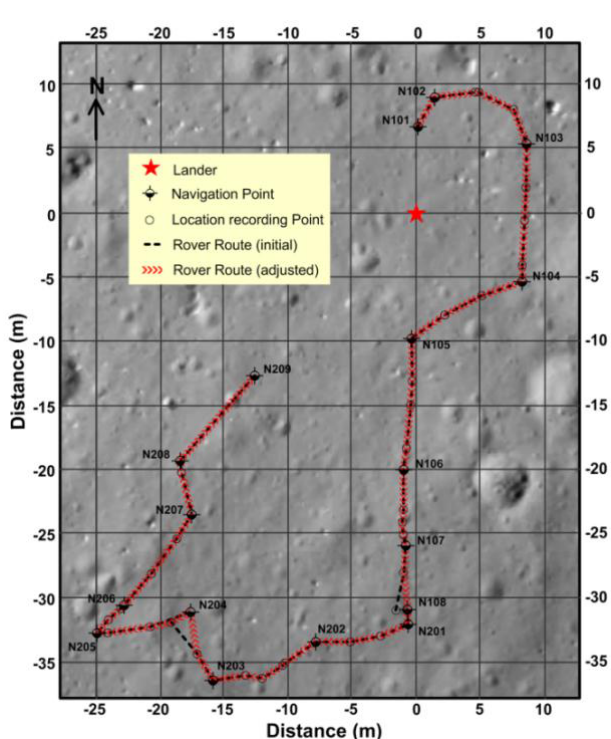
Figure 11. Yutu’s path on the Moon. The context image was taken by the descent camera on the CE-3 lander. The red star shows the landing site. The inset lines show the initial path (black dotted line) read directly from the Lunar Penetrating Radar (LPR) data and the adjusted path (red line). Sensors 2018 , 18 , x